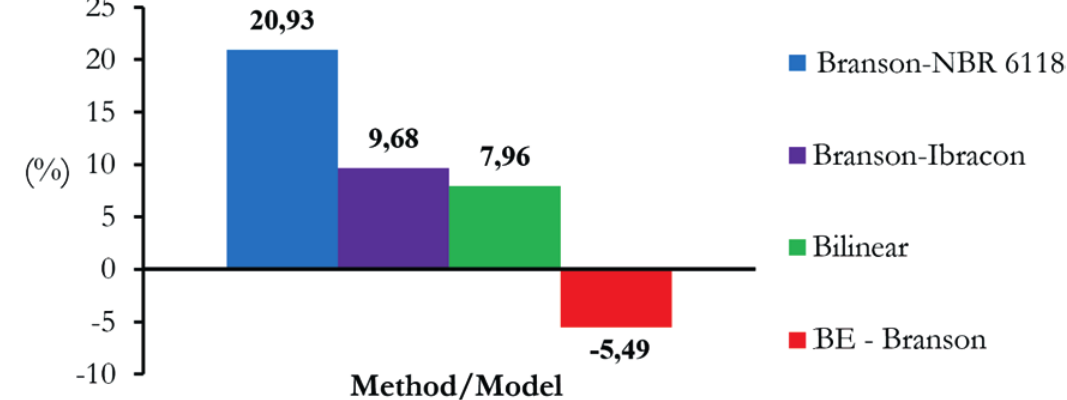
Graph of average percentage differences (%) between the final deflections found by the different methods and by the reference model, AM